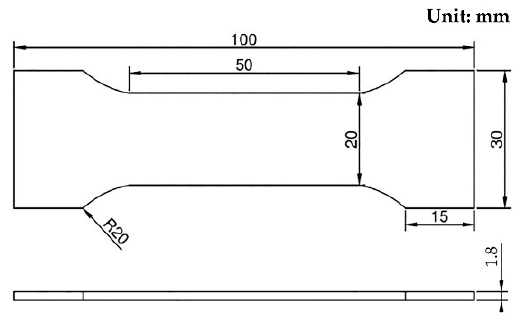
Figure 5. Dimension of tensile test specimen.